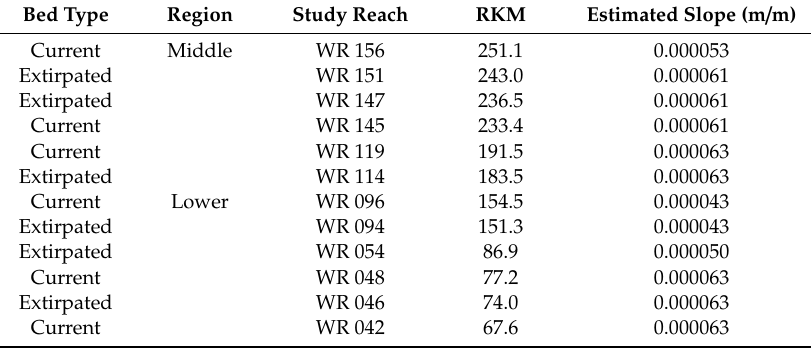
Table 1. Study reach slope values (m / m) estimated via USGS 7.5 min topographic maps and in-channel measured discharge (m 3 · s − 1 ) across bed types, two regions (Middle, Lower) and three sampling events (Spring, Autumn and Winter) for each of the 2004–2005 White River stations. RKM = river